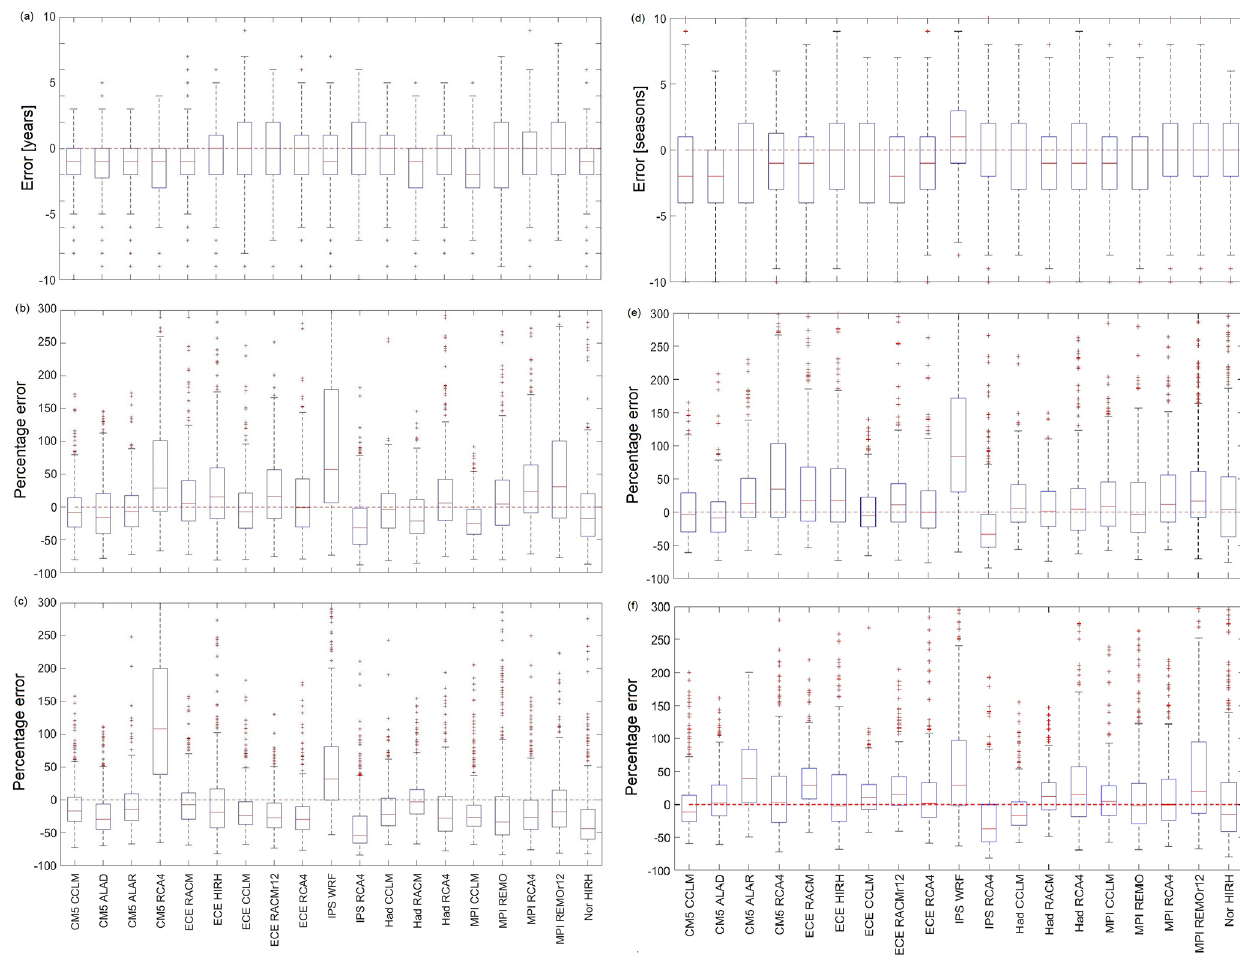
Figure 11. Box plots representing the frequency distribution of RCM percentage errors in (a) maximum drought duration (annual analy- sis), (b) maximum drought accumulated deficit (annual analysis), (c) maximum drought intensity (annual analysis), (d) maximum drought duration (seasonal analysis), (e) maximum drought accumulated deficit (seasonal analysis), and (f) maximum drought intensity (seasonal